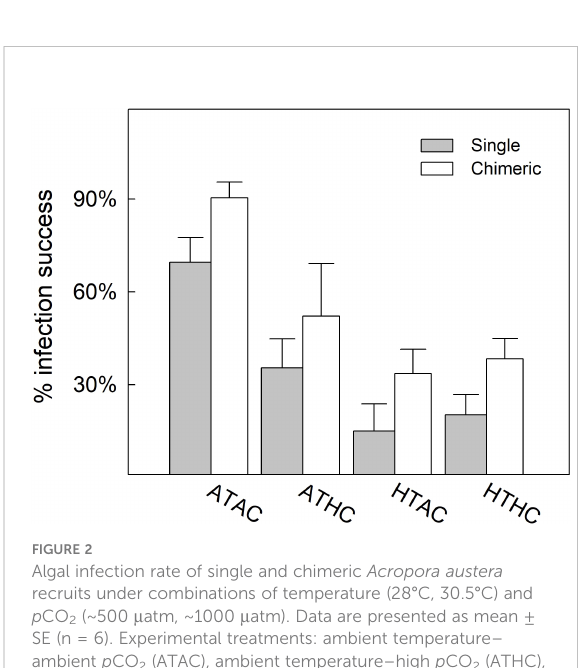
Signi fi cant results are highlighted in bold.